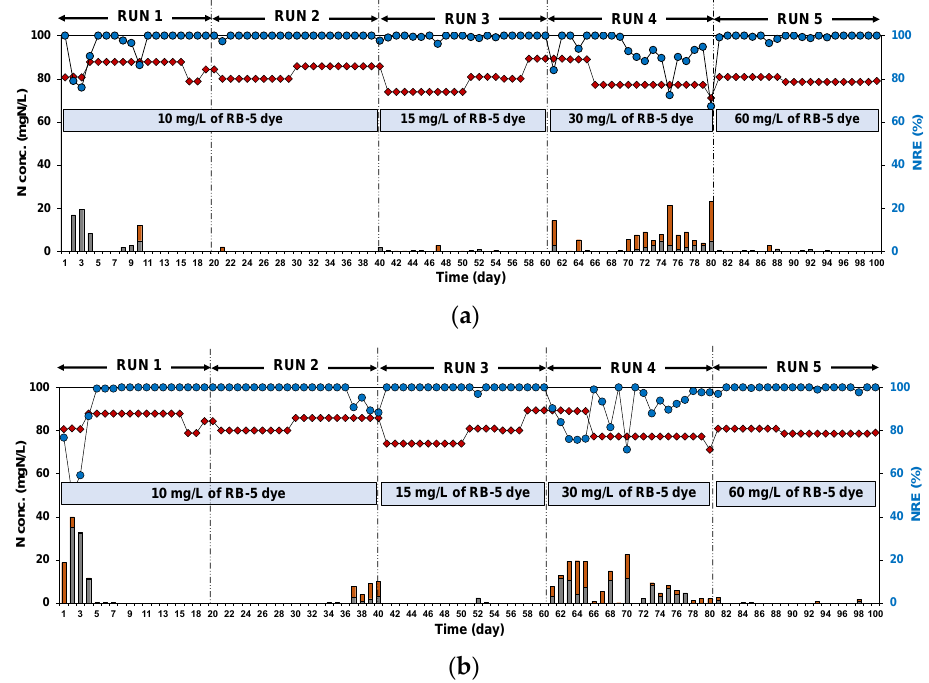
Figure 5. Concentrations of NO 3 –N and NO 2 –N in the effluent and NRE in ( a ) reactor A and ( b ) reactor B.